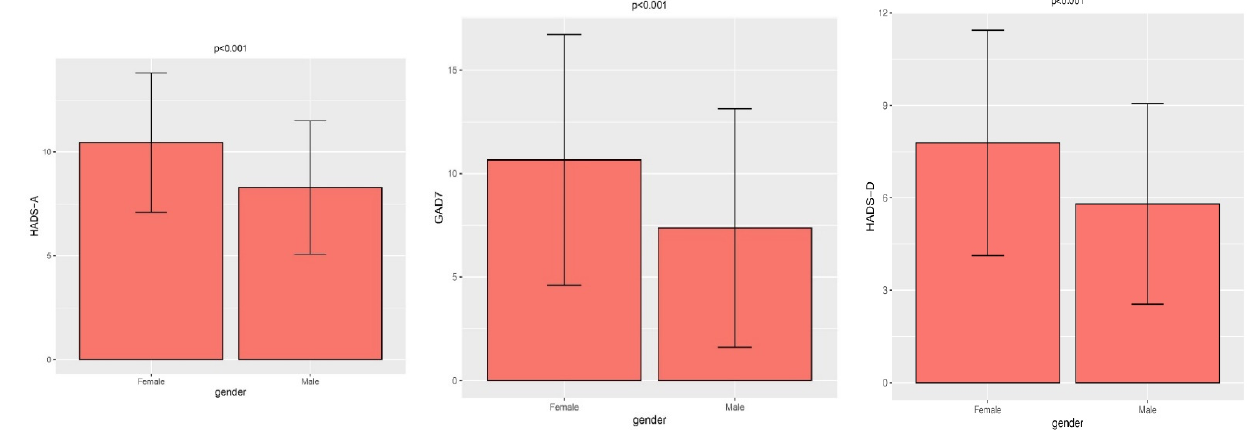
Figure 1. Comparison of HADS and GAD-17 scale values by gender using the Student t -test.